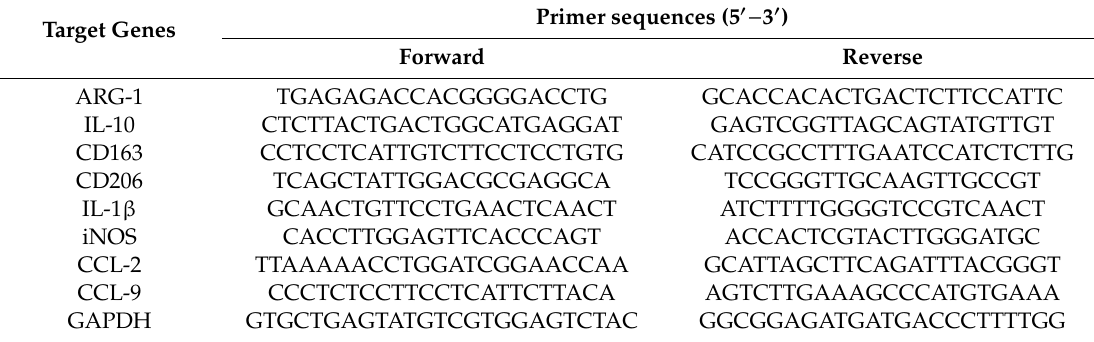
Table 1. Primer sequences for real time-quantitative polymerase chain reaction (RT-qPCR). Target